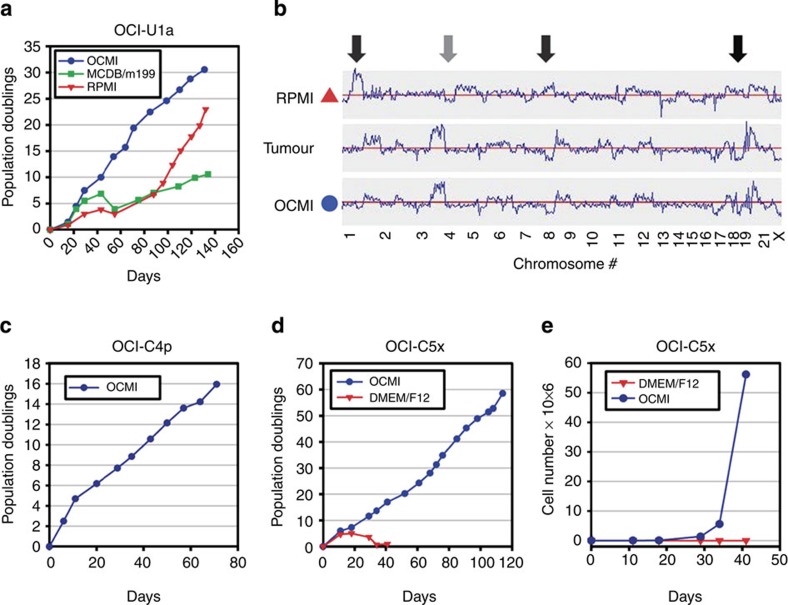
Long-term culture of ovarian tumours in OCMI media.(a) Cells from malignant ascites fluid-containing ovarian carcinoma cells (OCI-U1a) were plated in OCMI (blue line), MCDB105/M199 with 10% serum (green line) or RPMI-1640 with 10% serum (red line). A significant decrease in population doubling is observed in MCDB105/M199 and RPMI-1640 media after 7 weeks (green and red lines). This was not observed in OCMI, in which the cells reached 30 population doublings at cessation of the experiment. A fast proliferating cell population emerged in RPMI-1640 medium around day 90 (red line) and was established as a permanent cell line. (b) The whole-genome DNA copy-number variants (CNVs) of the OCI-U1a tumour cells cultured in OCMI and RPMI and from the paired uncultured tissue were examined using a 250-K SNP array. The CNV trace reveals several peaks that are gained (amplifications, black arrows) and lost (deletions, grey arrows) in tumour cells cultured in RPMI (top trace) compared with the uncultured tumour sample (middle trace). In contrast, the CNV pattern of tumour cells cultured in OCMI appears significantly more similar to the uncultured tumour (bottom and middle CNV traces, respectively). (c,d) The ovarian clear-cell lines OCI-C4p and OCI-C5x were cultured to at least 60 and 100 population doublings, respectively, in OCMI (blue line). In the control medium (DMEM:F12 with 10% serum) the cells stopped proliferating in 30–40 days (red line). (e) Total cell numbers were plotted instead of population doublings to highlight the scale difference in OCMI (blue line) versus DMEM:F12 with 10% serum (red line) depicted in d. See Supplementary Methods, Supplementary Figs 1–6 and Supplementary Tables 1–7 for more detailed cell line and tumour information.